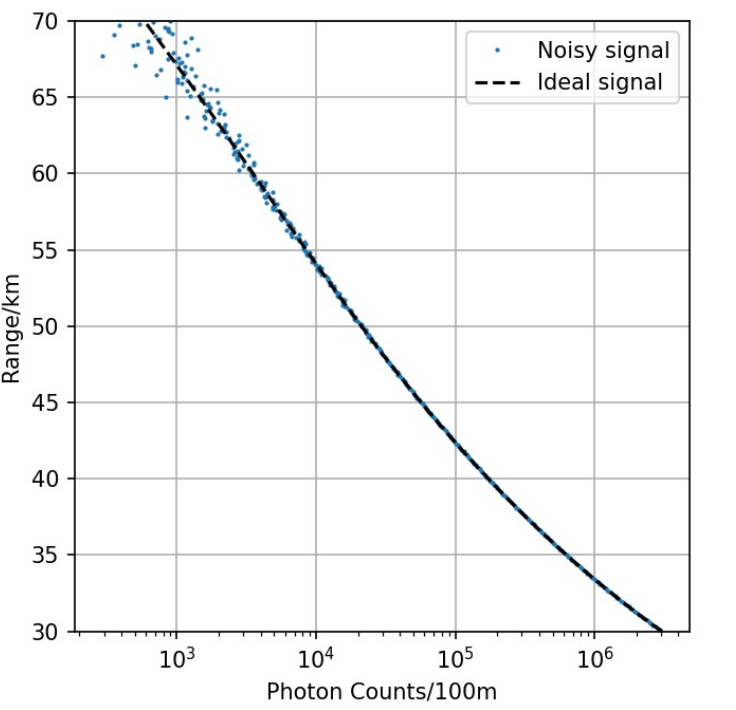
Figure 2. The ideal echo signals and the noisy signals in the case of integration time of 1200